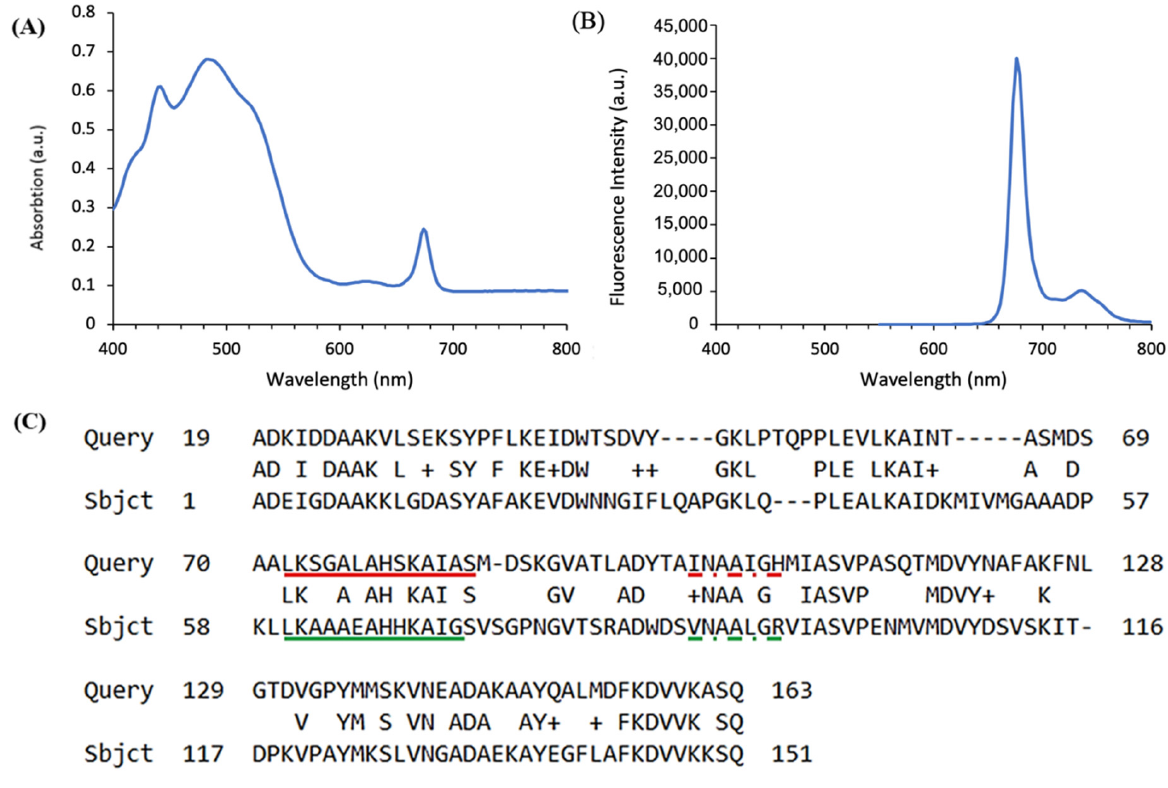
Figure 3. The absorption ( A ) and fluorescence emission ( B ) spectrum of PCP from S. tridacnidorum . Predicted PCP protein sequence alignment of S. tridacnidorum (query) and A. carterae (subject) ( C ). Query sequence matched to subject protein sequence with score 110 bits, expected value 3 × 10 − 25 , identity (73/155; 47%) and gaps (1/155; 9%). The solid lined peptide sequence is a possible Chl a binding site and dotted lined sequence is a possible peridinin-binding site in S. tridacnidorum (query) and A. carterae (subject) .